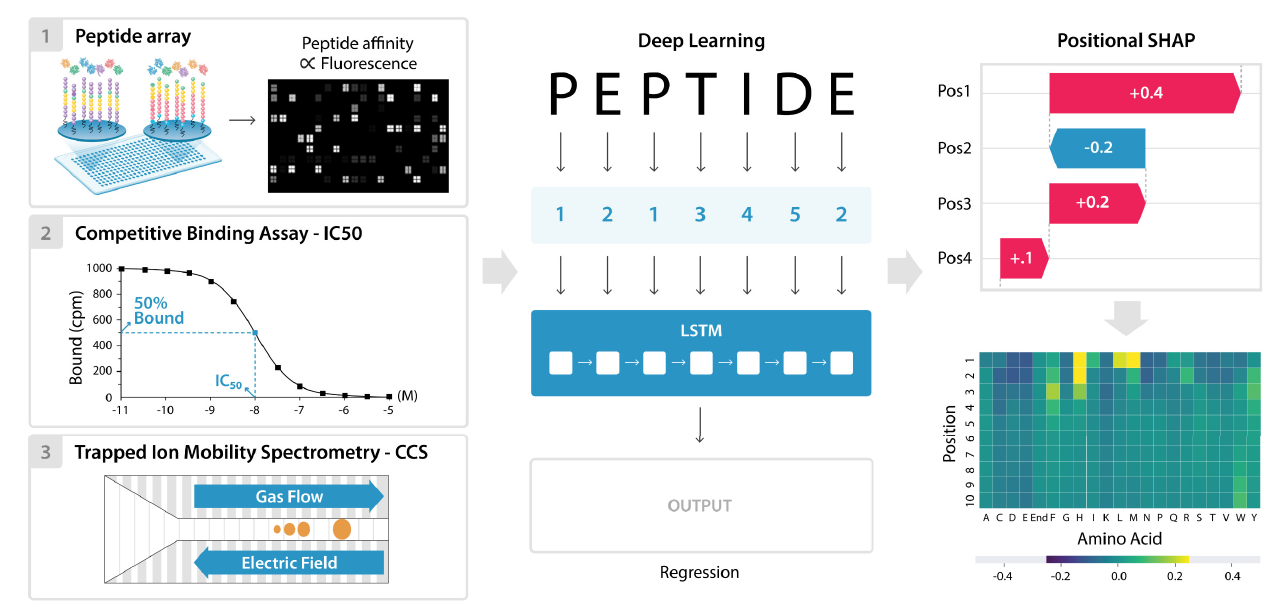
Fig 1. Overview of data, modeling, and positional SHAP analysis for model interpretation. Peptide sequence and output data was downloaded from Haj et al. 2020, Hu et al. 2019, and Meier et al. 2021, and used as an input for three separate deep learning models. The peptide sequences were numerically encoded, split to positional inputs, and Long Short-Term Memory (LSTM) models were trained to predict each of the outputs. These outputs included the five peptide array intensities for the Mamu MHC allele data, IC50 binding data for the human MHC A � 11:01 data, and CCS for the mass spectrometry data. The trained models were then used to make predictions on a separate test subset for each of the datasets. Finally, the model interpretation method SHAP was adapted to enable determination of each amino acid position’s contribution to the final prediction. This PoSHAP analysis was visualized by plotting the mean SHAP value of each amino acid at each position as a